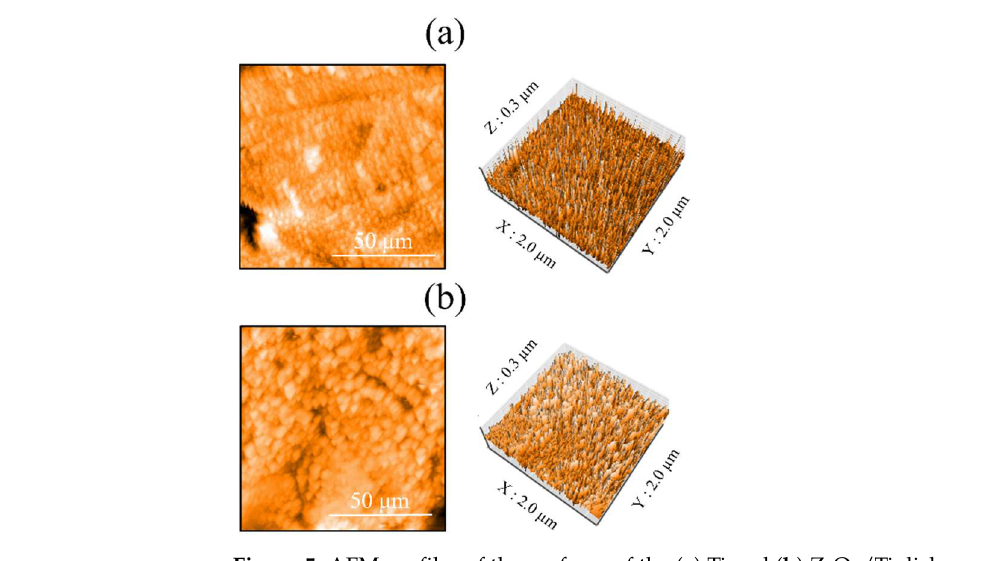
Figure 5. AFM profiles of the surfaces of the ( a ) Ti and ( b ) ZrO 2 /Ti disks. Table 1. Three-dimensional surface roughness (Sa) of Ti and ZrO 2 /Ti disks. Square Areas 10 µ m × 10 µ m 25 µ m × 25 µ m 50 µ m × 50 µ m